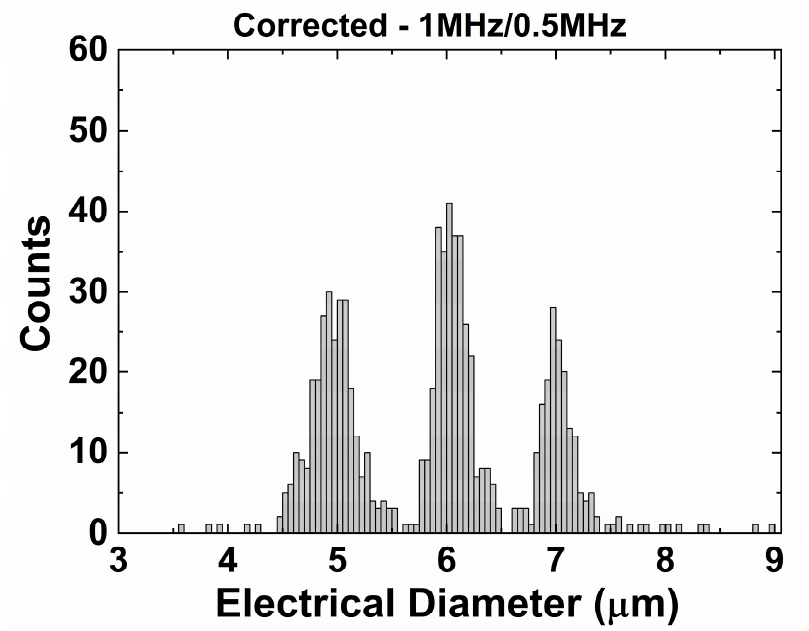
Figure 6. Opacity compensation using the same dataset as shown in Figure 5c. The 1 MHz signal was used as higher frequency to perform the opacity compensation.